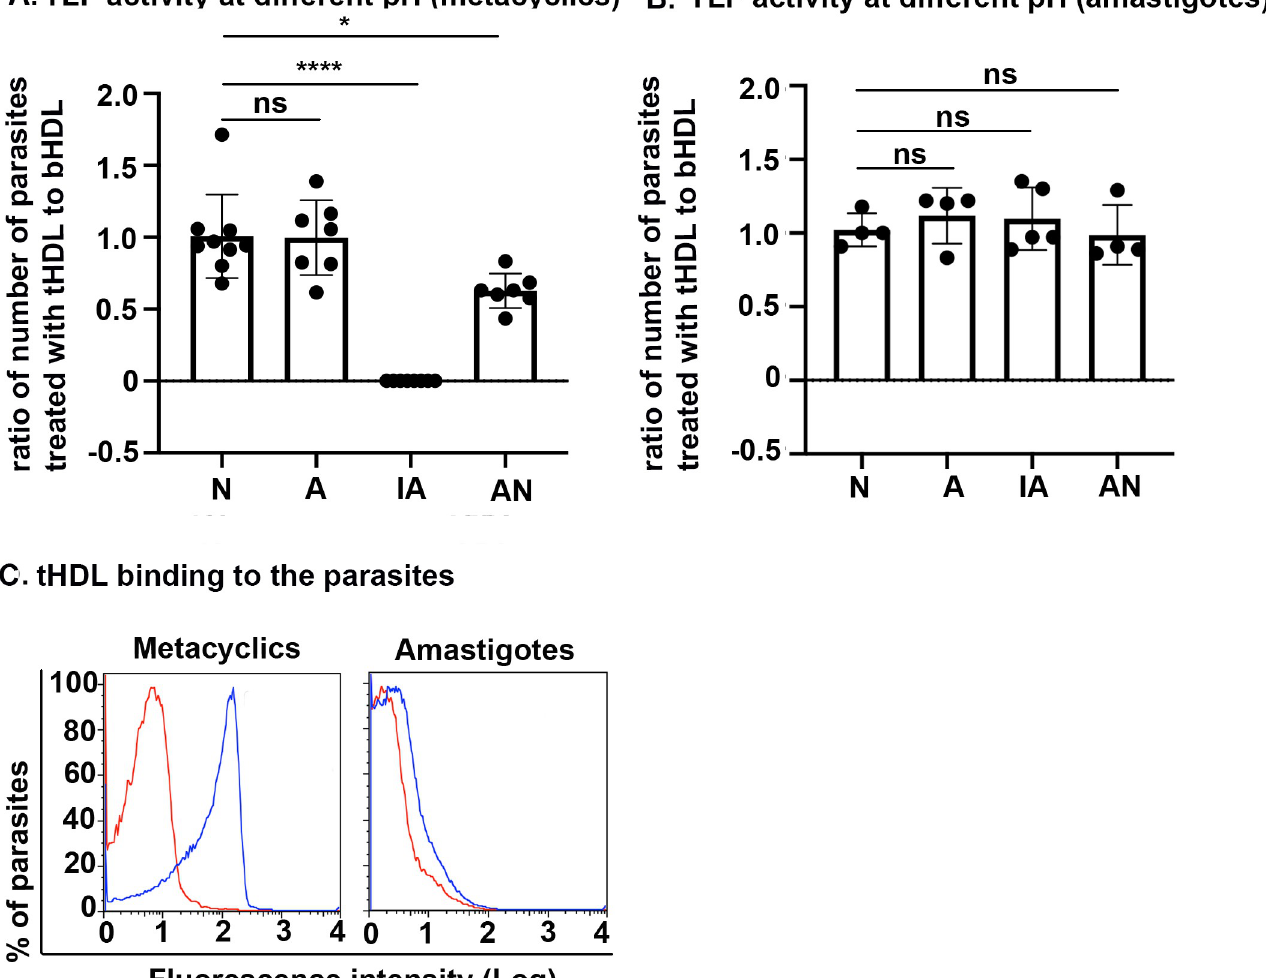
Fig 4. Acidic pH is essential for TLF-mediated lysis of L . amazonensis . A . Metacyclic promastigotes or B. amastigotes of L . amazonensis were treated with human HDL (1.5 mg/ml) or bovine HDL (1.5 mg/ml) and incubated in different conditions; Neutral—N pH 7.4 for 2 hours, Acidic–A pH 5.6 for 2 hours, Increased acidification- IA pH 5.6 for 1 hour followed by pH 4.5 for 1 hour, and Acid and Neutral- AN pH 5.6 for 1 hour followed by pH 7.4 for 1 hour. Parasites were microscopically counted using a hemocytometer. The data represent the means ± standard deviation of three experiments that have been combined. ���� p < 0.0001, ns- non-significant, ANOVA test, multiple comparisons with Bonferroni correction. C. L . amazonensis metacyclic promastigotes or axenic amastigote forms (1x10 6 /ml) were treated with 10 μ g/ml of DyLight-488 labelled tHDL (TLF, blue) or not (red) for 30 min on ice. Fluorescence intensity was quantified by flow cytometry. The data represent one typical experiment repeated three times.